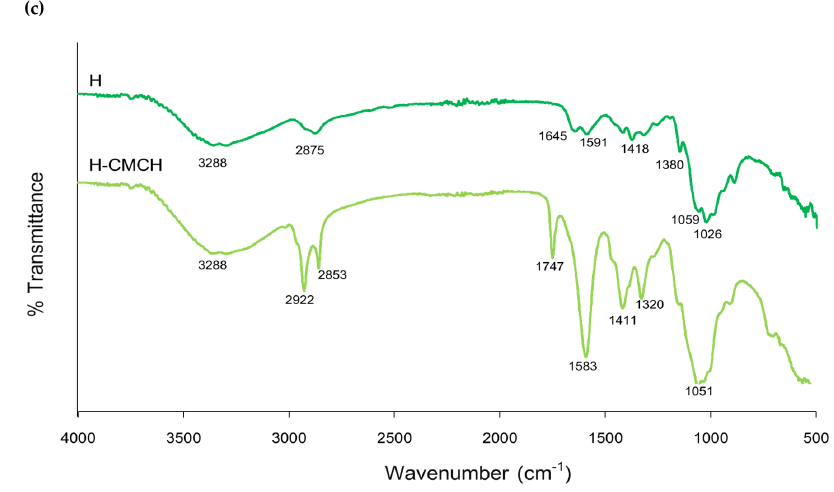
Figure 1. FT-IR spectra of ( a ) L and L-CMCH; ( b ) M and M-CMCH; ( c ) H and H-CMCH. Table 2. Functional groups and wave number (cm − 1 ) of chitosan and CMCH. Table 1. Yield, moisture content, water solubility, viscosity and pH of carboxymethyl chitosan (CMCH) with di ff erent MW.